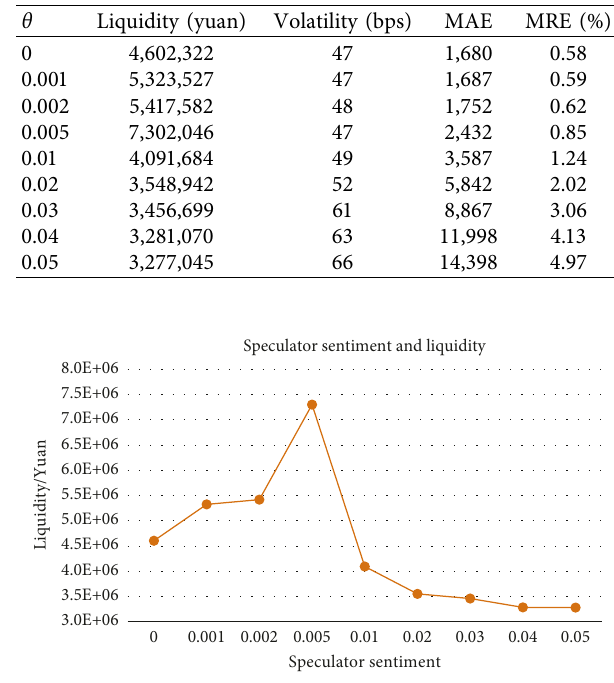
Figure 2: Trends in speculator sentiment and market